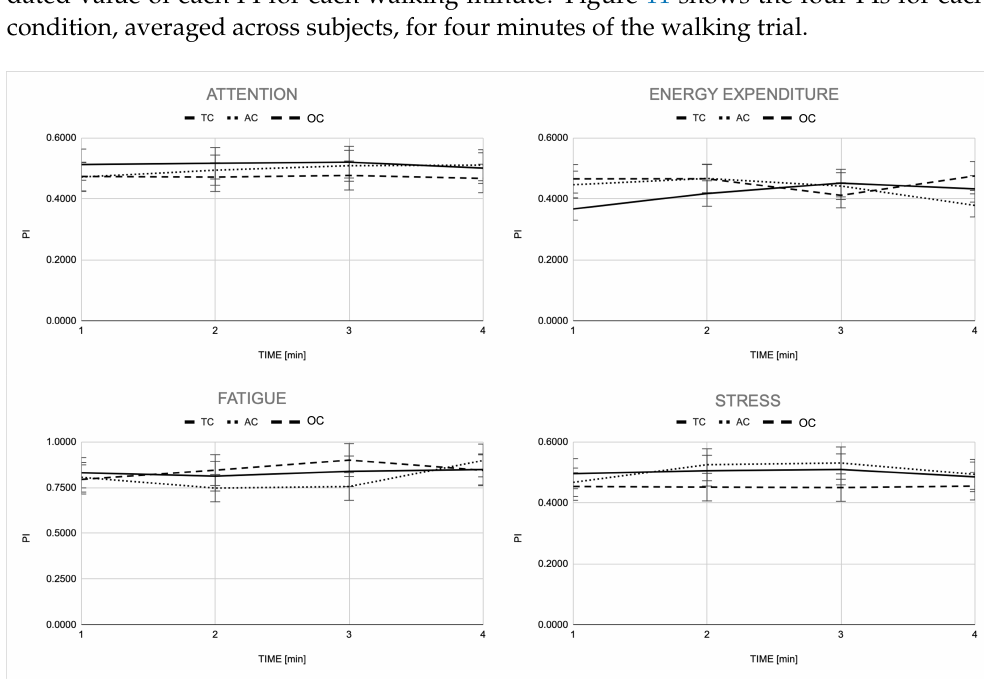
Figure 11. Average scores of Attention, Energy expenditure, Fatigue and Stress PIs for TC, AC and OC controllers. Scores of each PI were updated for each minute of